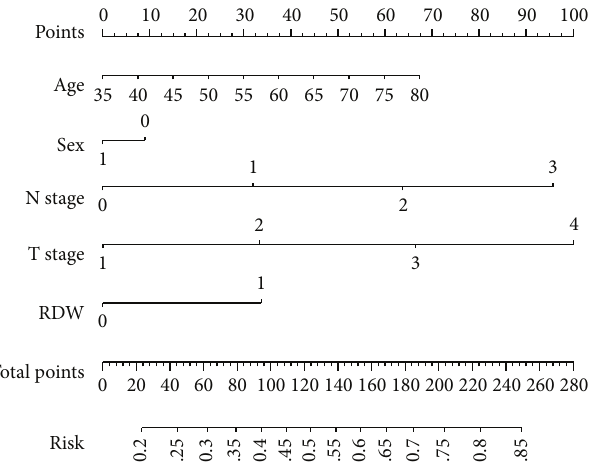
Figure 4: A nomogram predicts survival prediction based on RDW and other prognostic factors in patients with ESCC. The nomogram is used by totalling the points identified at the top of the scale for each independent factor. This total point score is then identified on the total points scale to determine the probability of risk prediction. Harrell’s c-index for CSS prediction was 0.68. For example, a female (9 points) patient aged 60 years (38 points) with T2 (33 points), N1 (31 points), and RDW ≥ 14.5% (33 points) would score 144 total points which converts to a risk probability for death of